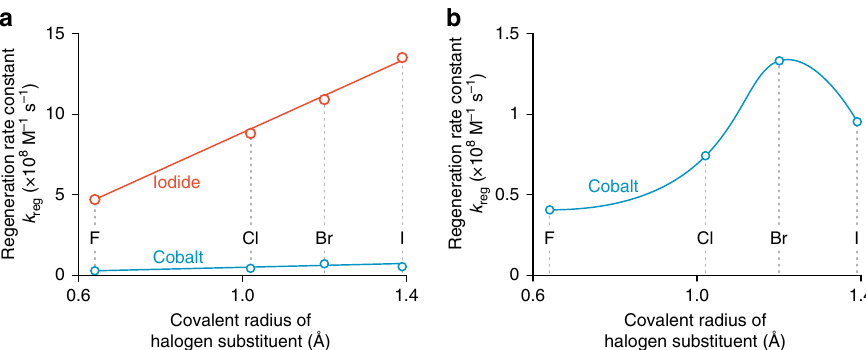
Fig. 6 Regeneration rate is proportional to halogen polarizability. a Regeneration rate constants ( k reg ) for the reaction of Dye-X • + (X is F, Cl, Br, I) on titanium dioxide (TiO 2 ) substrates with 0.5 – 10 mM of I − (red) or 10 – 150 mM of [Co(bpy) 3 ] 2+ (blue). Dye-X • + is created through 532 nm